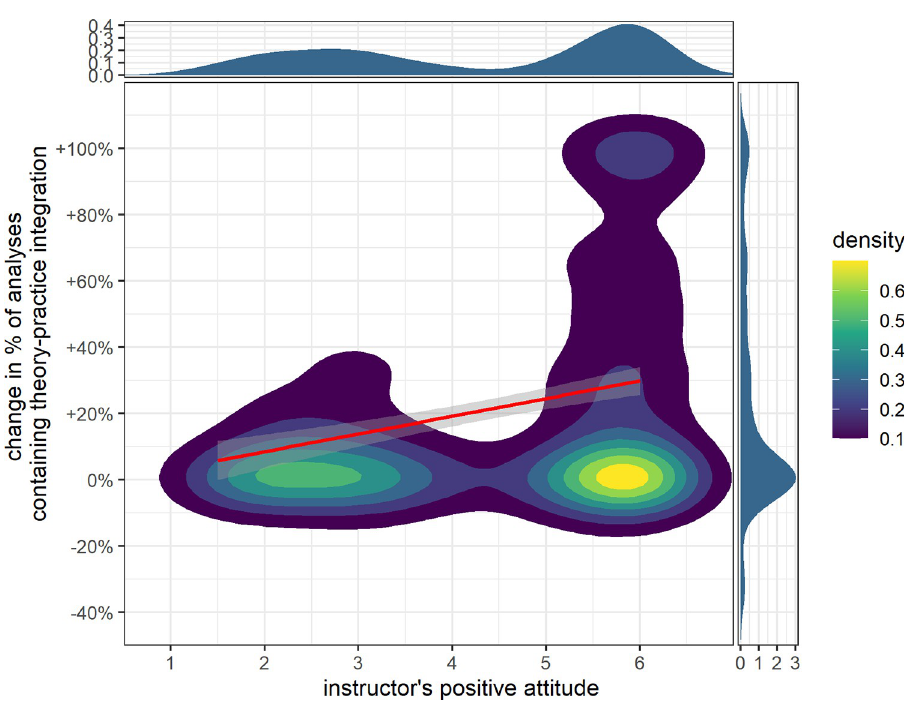
Fig 3. Two-dimensional density plot of change from pretest to posttest in theory-practice integrations and the instructors’ positive attitudes.